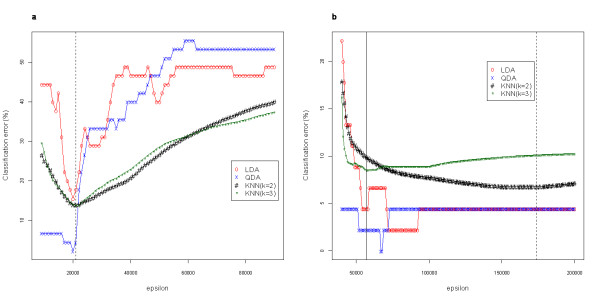
Parameter optimization plot for microarray example. Classification error rates for primary fibroblast cell lines between three separate species determined by different epsilon values for (a) the spectral method from Ng et al. and (b) kernel PCA. Epsilon values were increased to 5 × 109 to assess classification accuracy (data not shown), but truncated for the plot to better visualize the global minima for each classifier method. The spectral method from Lafon has a 0% error rate across all methods except LDA, where only one sample is misclassified.